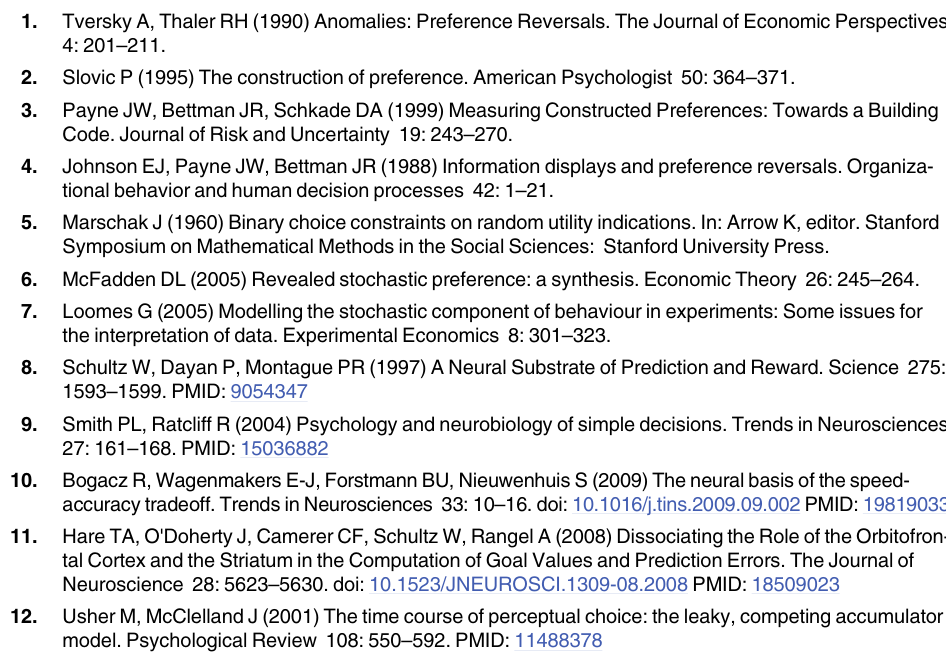
S2 Table. Value ranges and parameters used in the original food study and the social-pref- erence Tasks 1 – 4 of the current study. S3 Table. Payoffs for the dictator (self) and receiver (other) for the two options in Task 1. Points were converted to Swiss Francs at the end of the experiment. S4 Table. Payoffs for the dictators (self) and receiver (other) for the two options in Tasks 2 & 3. Points were converted to Swiss Francs at the end of the